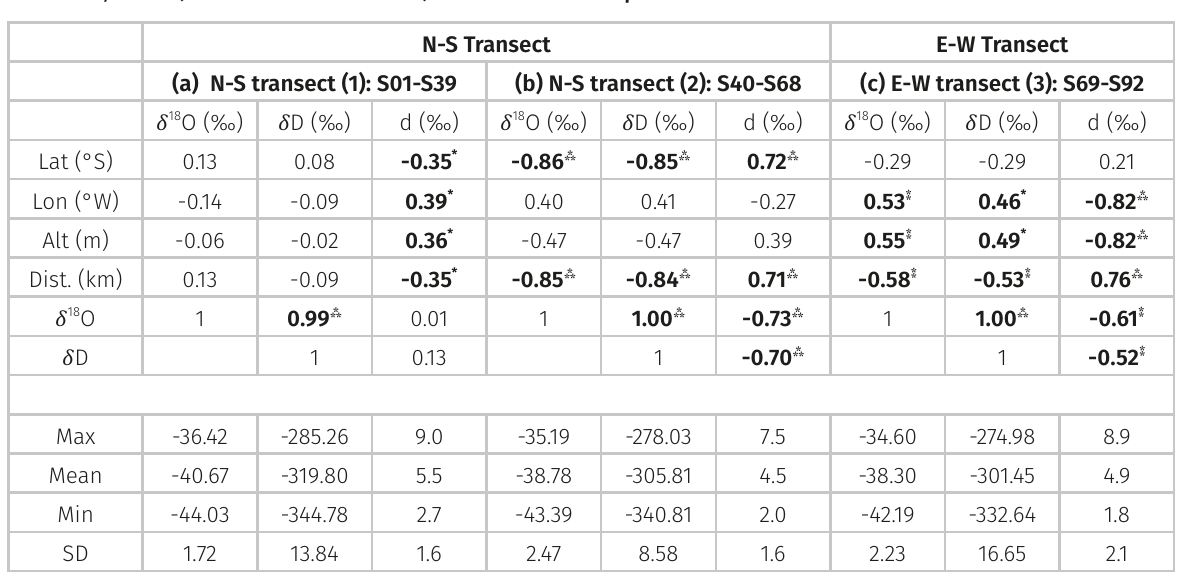
18 O, D and d-excess) and 𝛿 𝛿